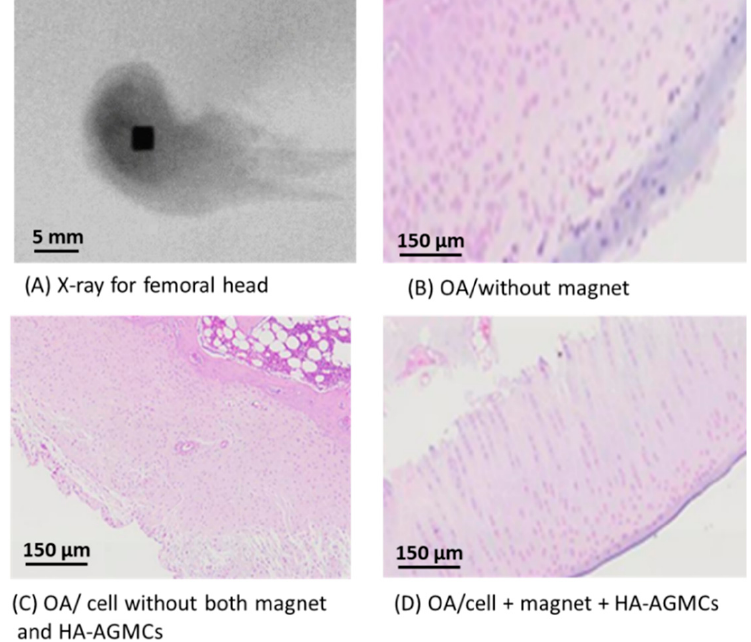
Figure 8. ( A ) Half of the rabbit’s femoral head implanted with a magnet as a source of magnetic force. H&E stain of the cartilage tissue treated with various groups of cells / magnet / HA-AGMCs for 4 weeks in ( B – D